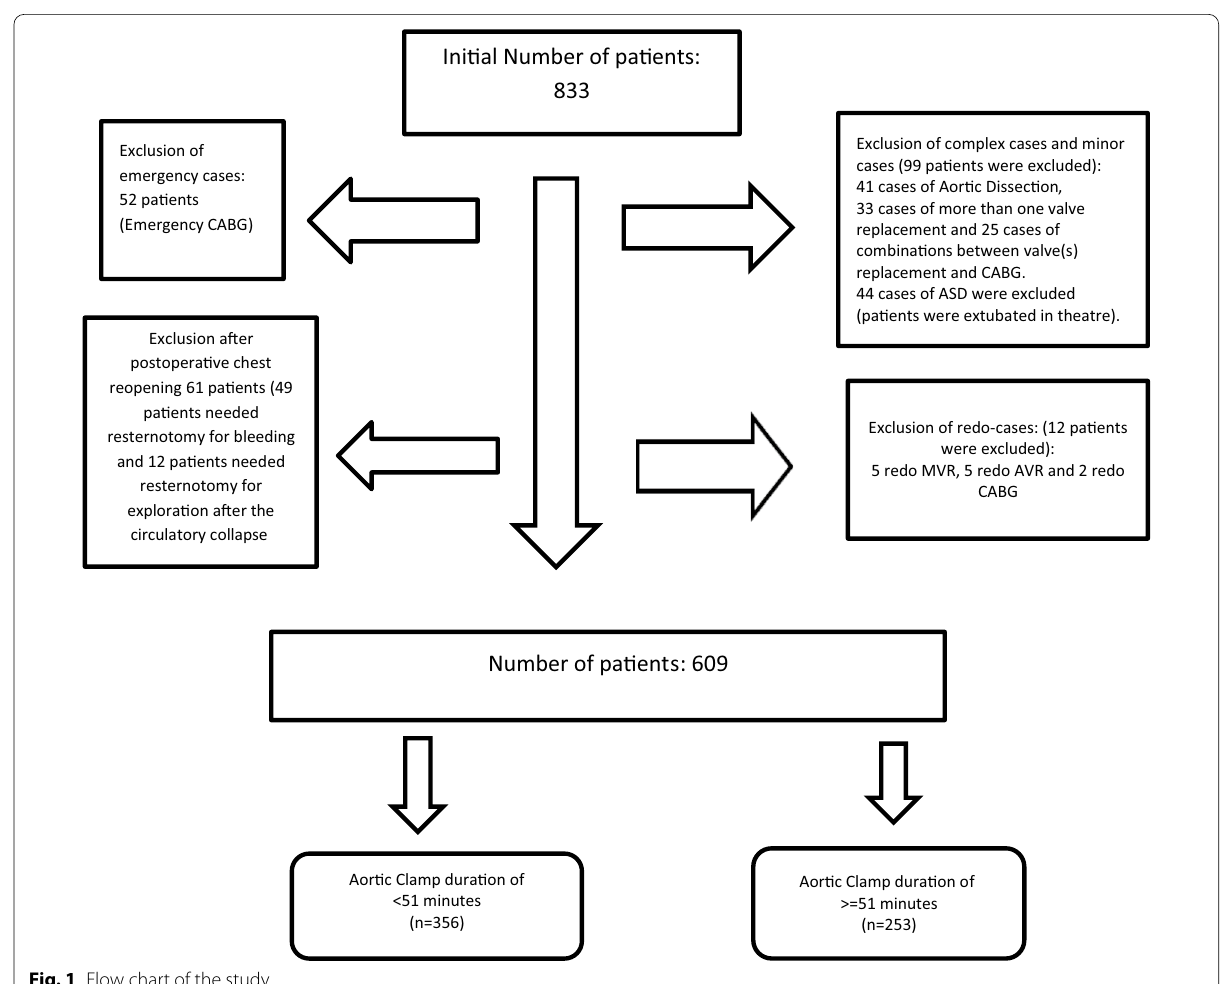
Fig. 1 Flow chart of the